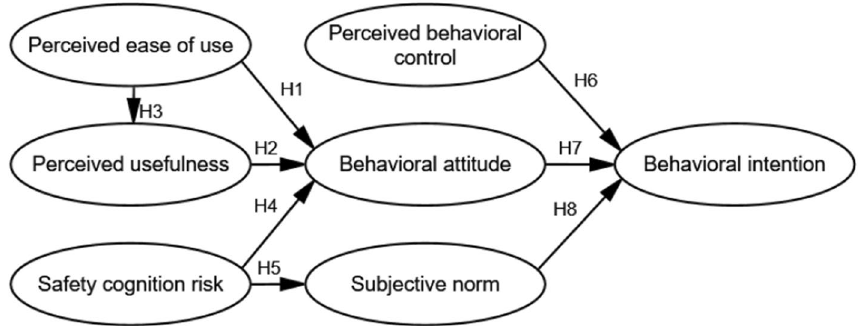
Figure 2. Structural relationship diagram of acceptance model of ADT.